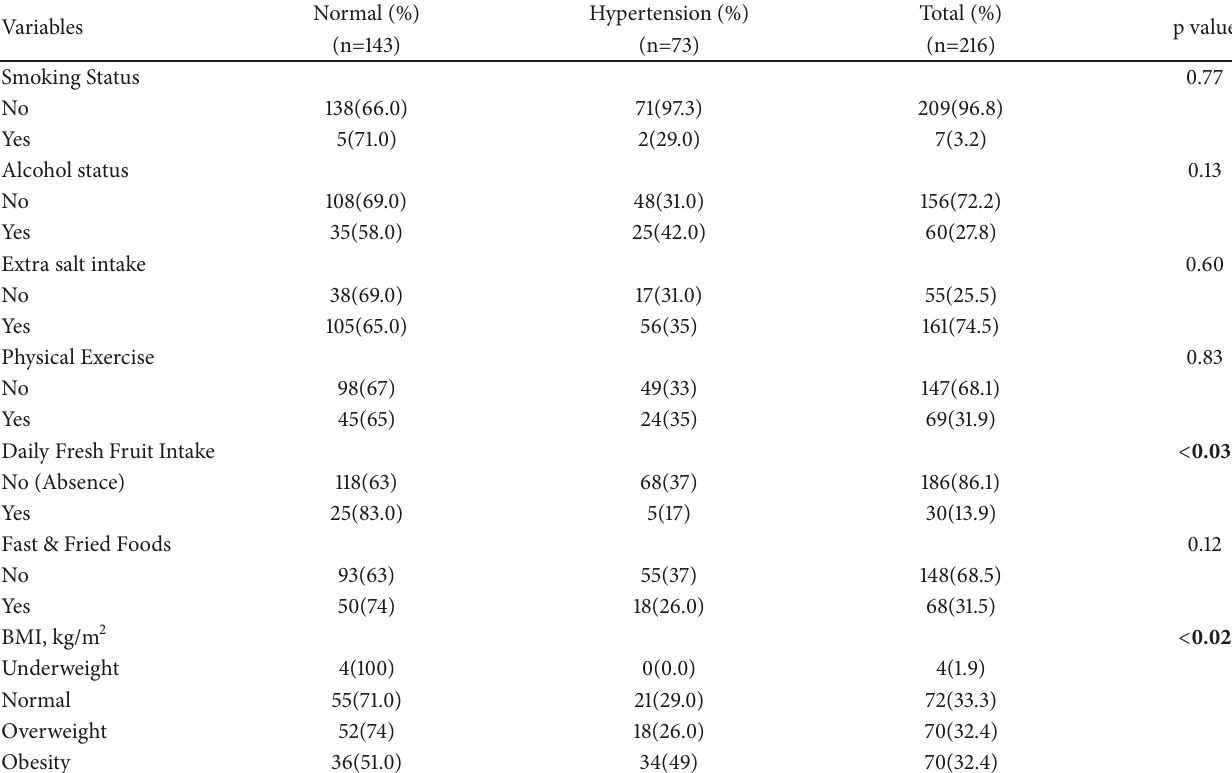
Table 3: Prevalence of hypertension by lifestyle and comorbidities